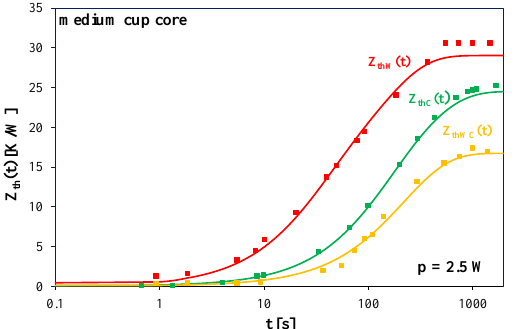
Figure 9. Measured and calculated waveforms of transient thermal impedances of the inductor containing the toroidal core 16.